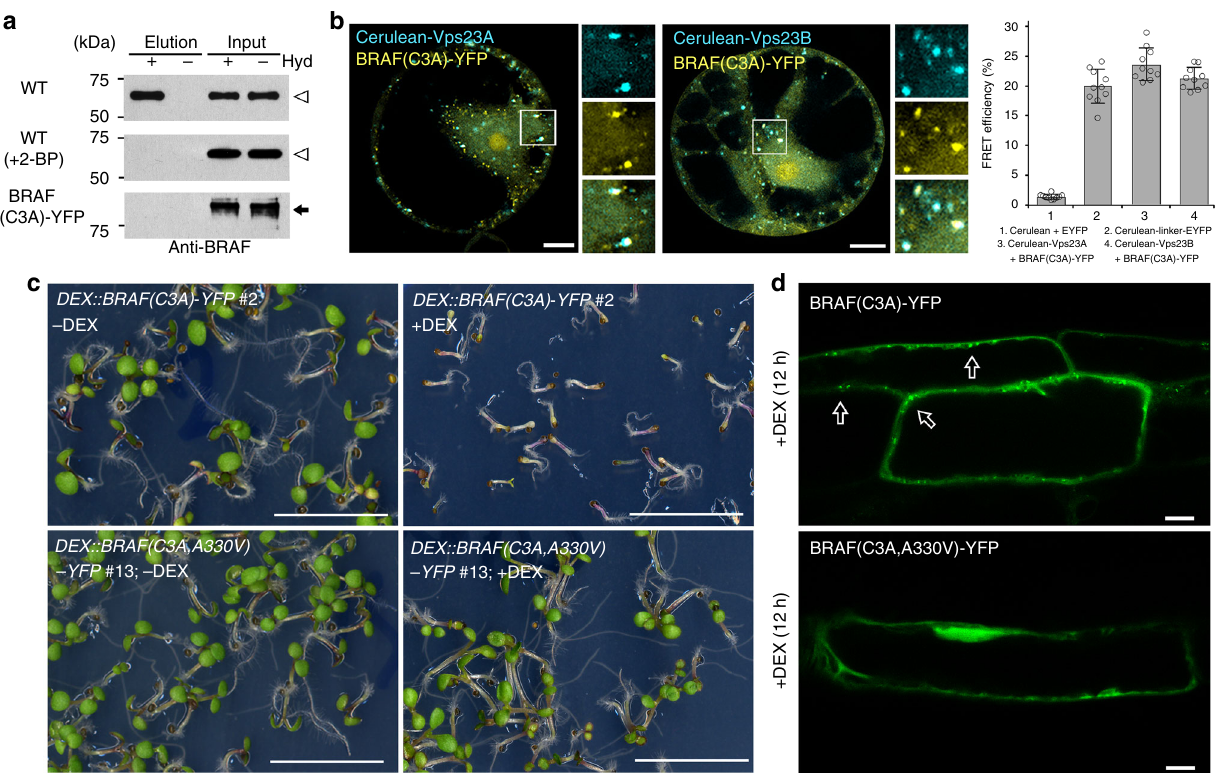
Fig. 6 BRAF is S -acylated and the de-acylated BRAF(C3A)-overexpressing mutant seedling is lethal. a Biotin switch assaying the S -acylation of BRAF proteins. Total membranes were puri fi ed from Arabidopsis protoplasts and subjected to the biotin switch assay. Samples were treated with ( + ) or without ( − ) the thioester cleavage reagent hydroxylamine (Hyd). The loading controls (Input) show that equal amounts of BRAF were loaded onto neutravidin beads. The lanes “ Elution ” show the degree of BRAF recovered from neutravidin beads. Arrowhead indicates endogenous BRAF protein. Protoplasts without transformation were treated with 10 µ M 2-BP for 24 h before assay (middle panel). BRAF(C3A)-YFP (arrow) was transiently expressed in the Arabidopsis protoplasts (low panel). b FRET analysis of the colocalized punctae between BRAF(C3A)-YFP and the two Vps23 homologs (Cerulean-Vps23A and Cerulean-Vps23B) showed interactions. FRET ef fi ciency was quanti fi ed by using the acceptor photobleaching approach on the right. For each group, 10 individual protoplasts were used for FRET ef fi ciency quanti fi cation and statistical analysis. Error bars are the S.D. of FRET ef fi ciency. c Seedlings expressing DEX::BRAF(C3A)-YFP , but not DEX::BRAF(C3A,A330V)-YFP , are lethal after DEX incubation. The phenotype of 7-day-old seedlings of indicated genotypes growth on MS plates supplied with ( + ) or without ( – ) DEX. Scale bar, 1 cm. d Confocal imaging analysis of the differential intracellular distribution of BRAF (C3A)-YFP and BRAF(C3A,A330V)-YFP in Arabidopsis root cells. Six-day-old transgenic Arabidopsis plants were transferred into liquid medium containing 30 μ M DEX for 12 h to induce the expression of YFP fusions. BRAF(C3A)-YFP are predominantly found in vesicles, while BRAF (C3A,A330V)-YFP signals shown in cytosol. Scale bar, 10 μ